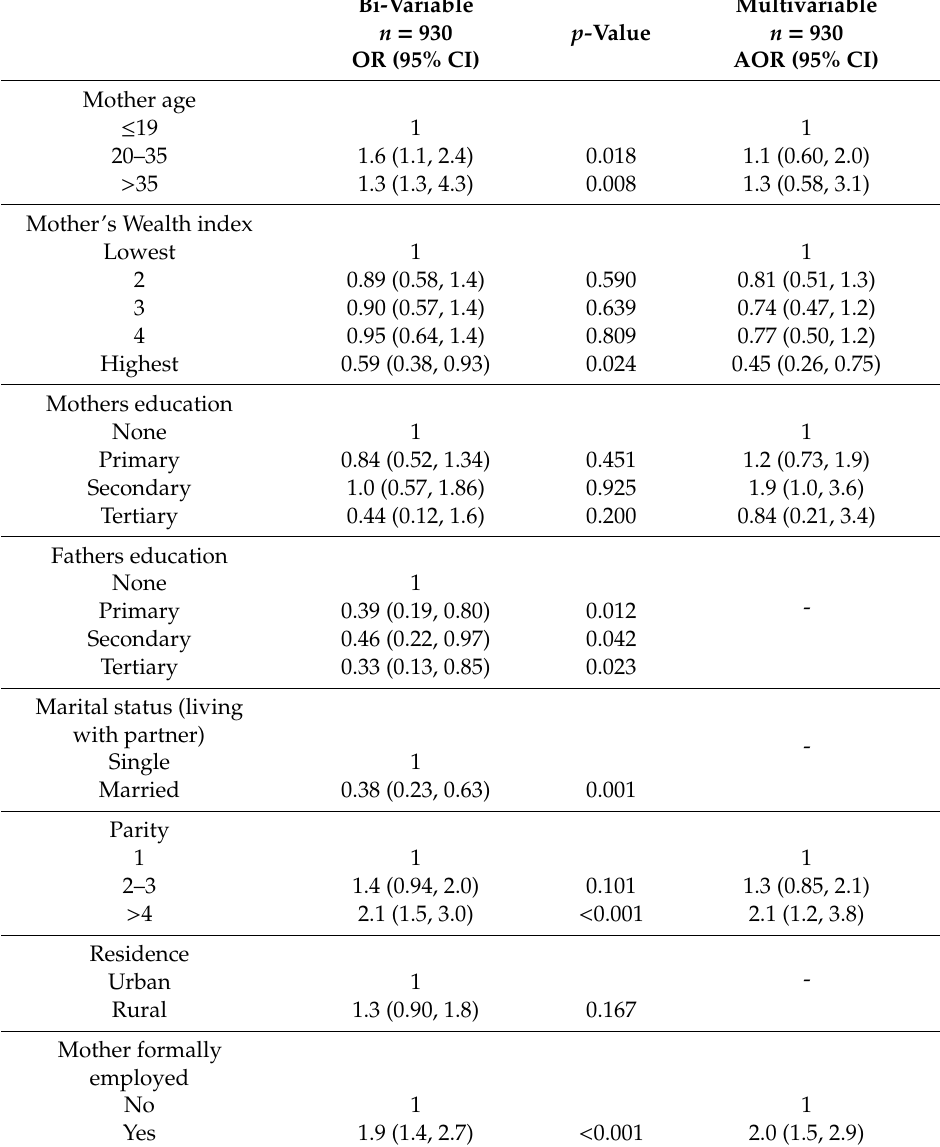
Table 4. Factors associated with mothers being key decision makers on place of birth in the Lira district, Northern